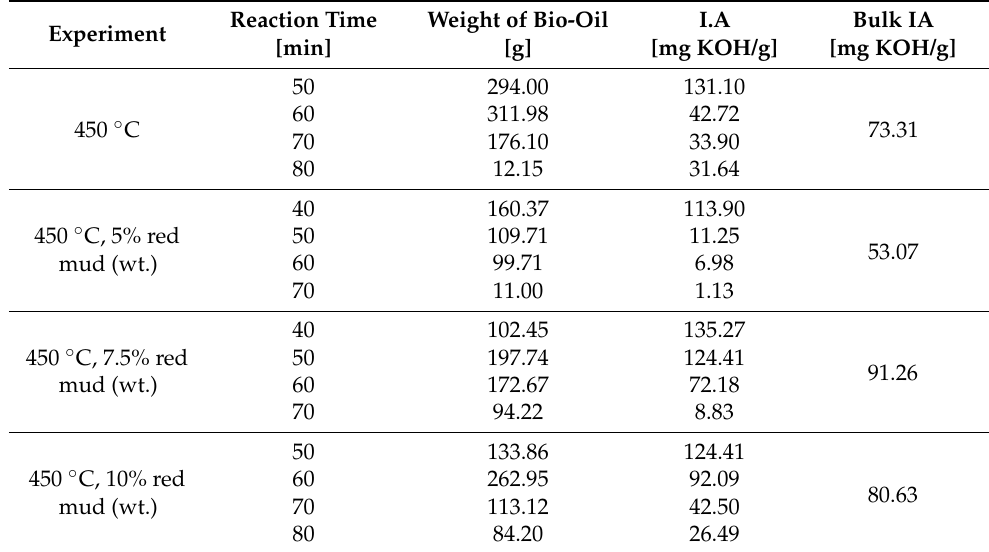
Table 9. Bulk acid value of bio-oils obtained with and without catalyst.